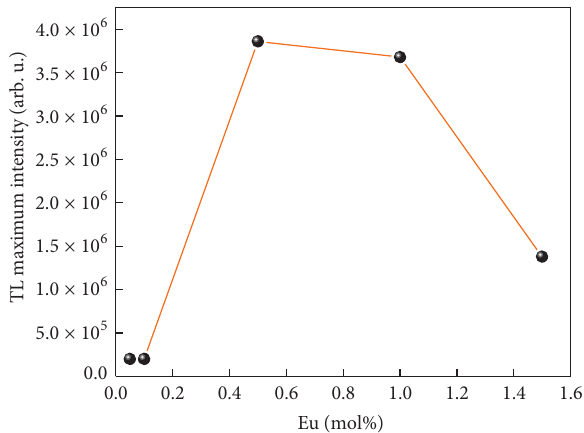
Figure 1: Intensity of the thermoluminescence emission maximum of CaSO 4 :Eu samples, for 0.1, 0.5, 1.0, and 1.5mol% Eu concentra- tions.